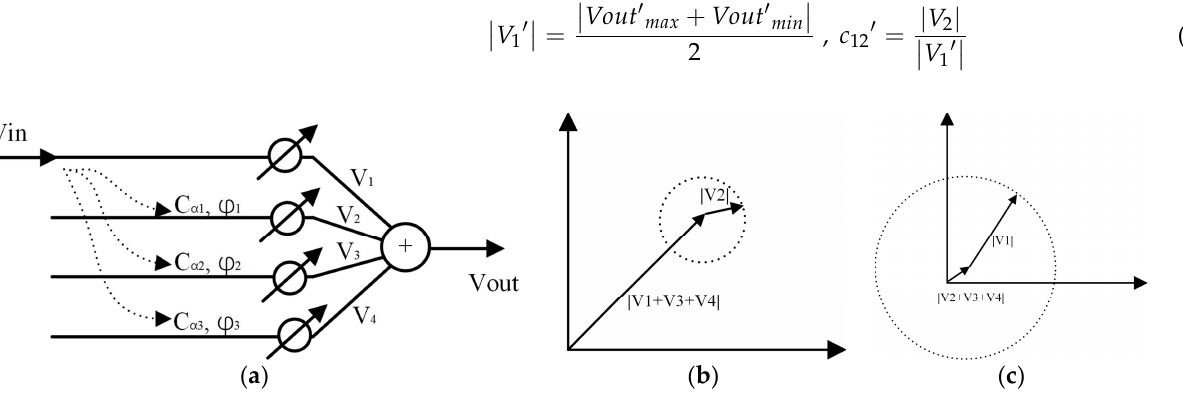
Figure 18. ( a ) Measurement model of channel mutual coupling. ( b ) Changing model of Vout when changing the phase of channel 2. ( c ) Changing model of Vout when changing the phase of channel